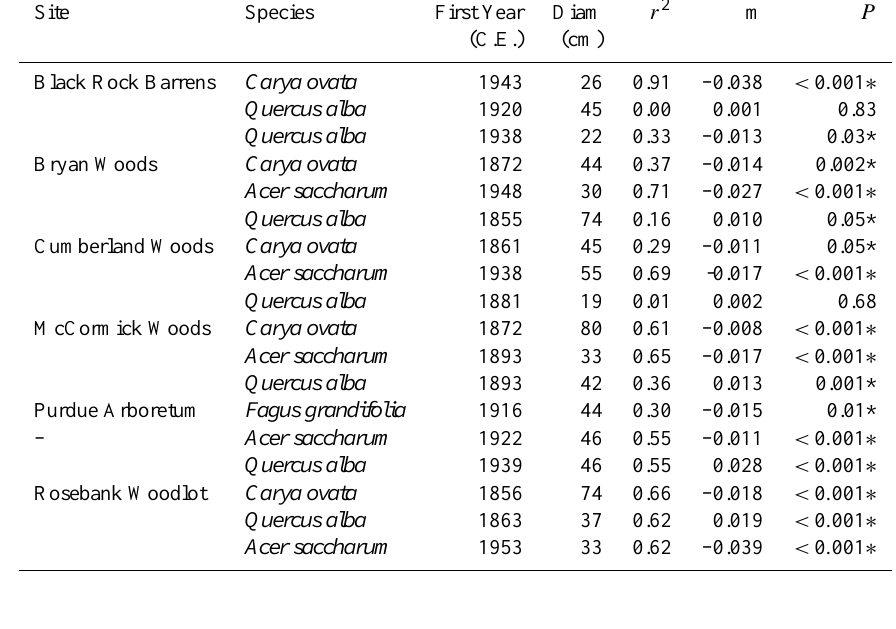
Table 1. Simple linear regressions between wood δ 15 N and year of wood formation for eighteen trees sampled in Indiana, USA. The slope is since 1900. Tree diameter (diam) is based on the length of increment core. First year is the earliest date for wood analyzed, not the pith date or year established.